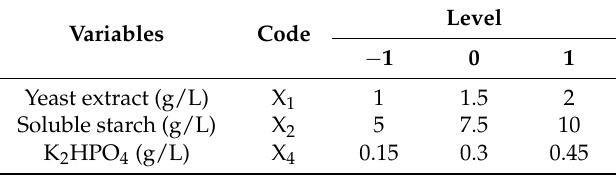
Table 2. The level of variables for the Box-Behnken design.